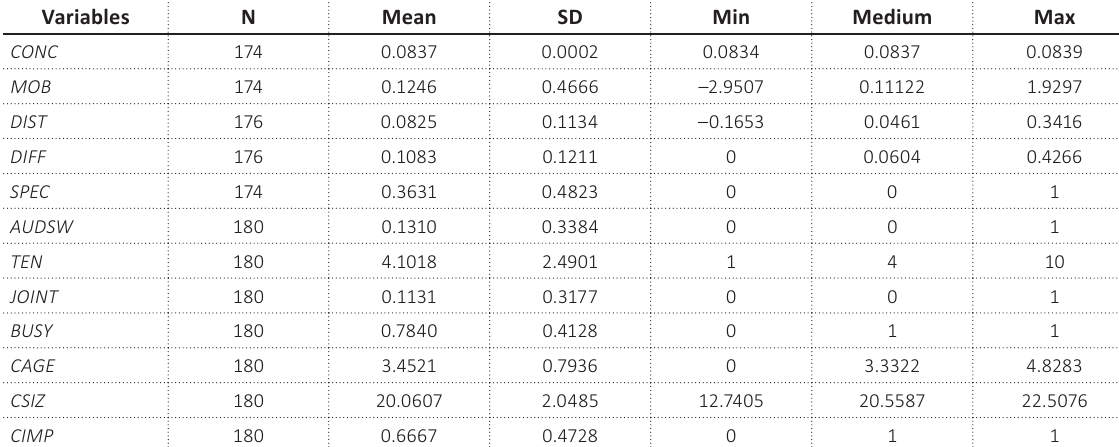
Table 2. Descriptive statistics